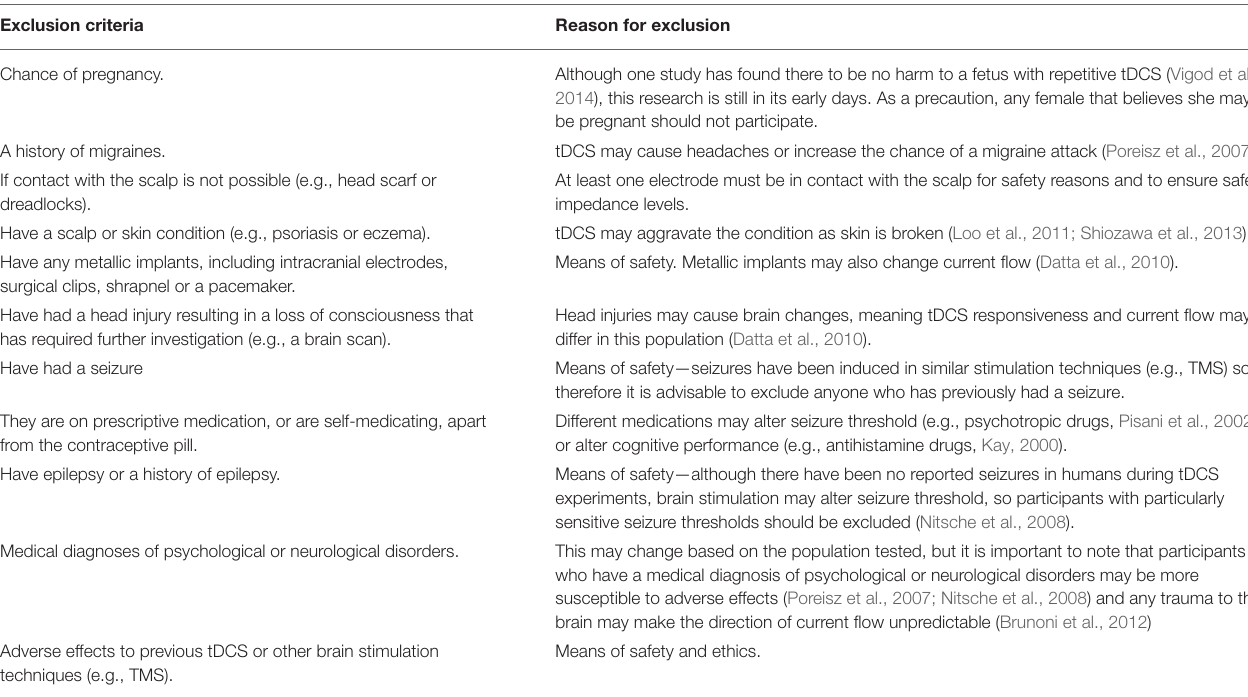
TABLE 2 | Common exclusion criteria for tDCS participant